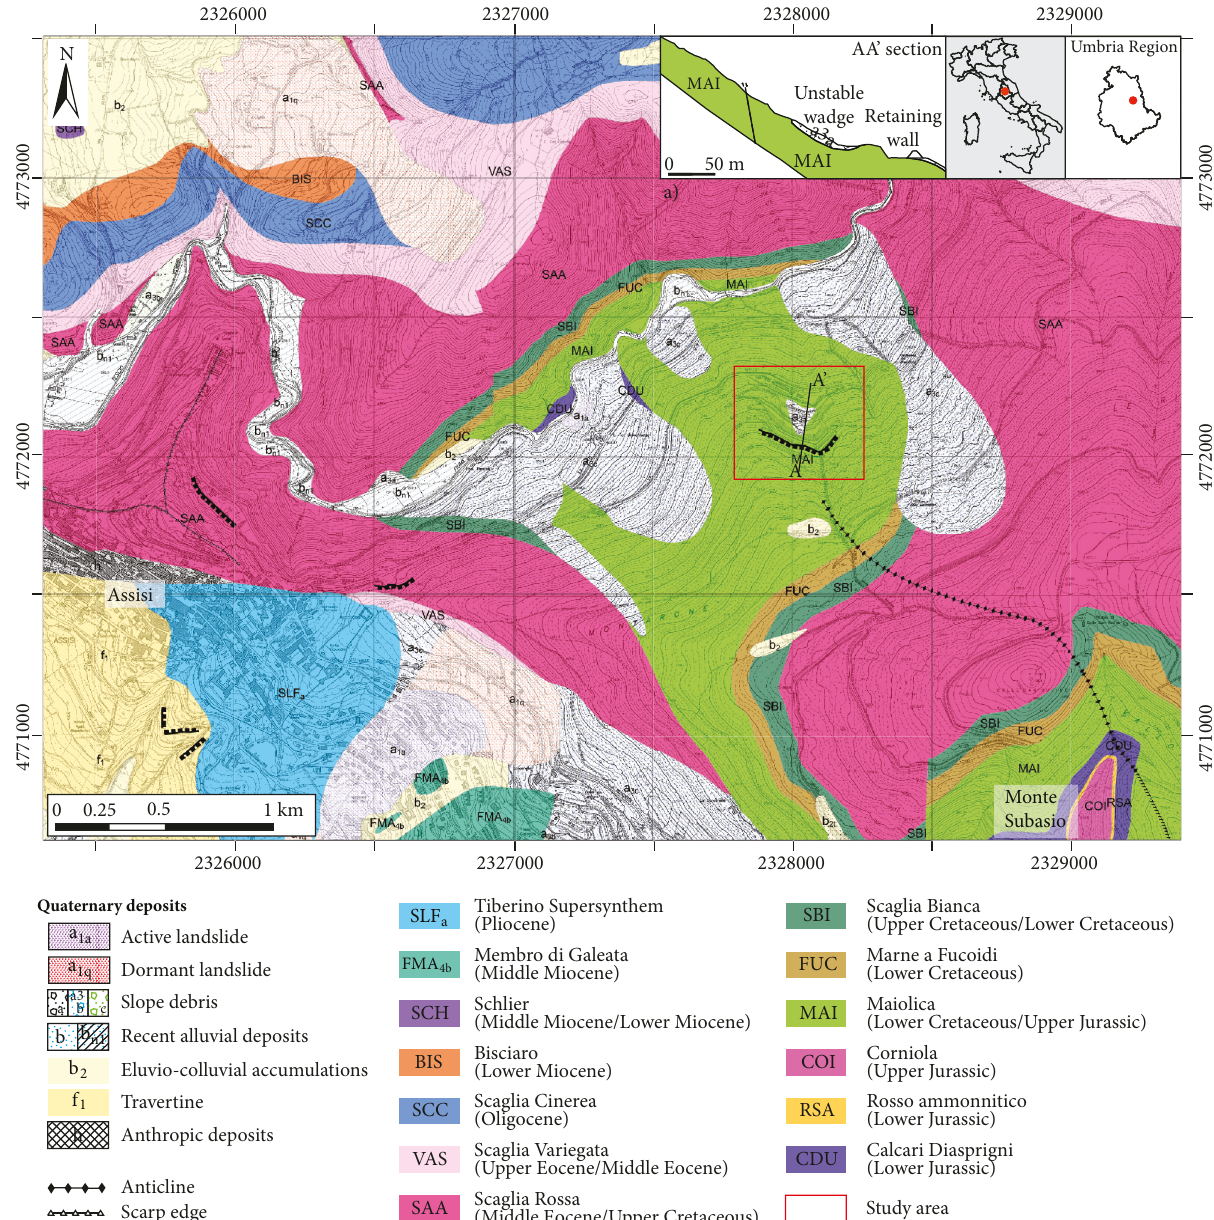
Figure 1: Geological map of the study area. (a) Geological cross-section of the investigated slope (modified from Balducci et al.,